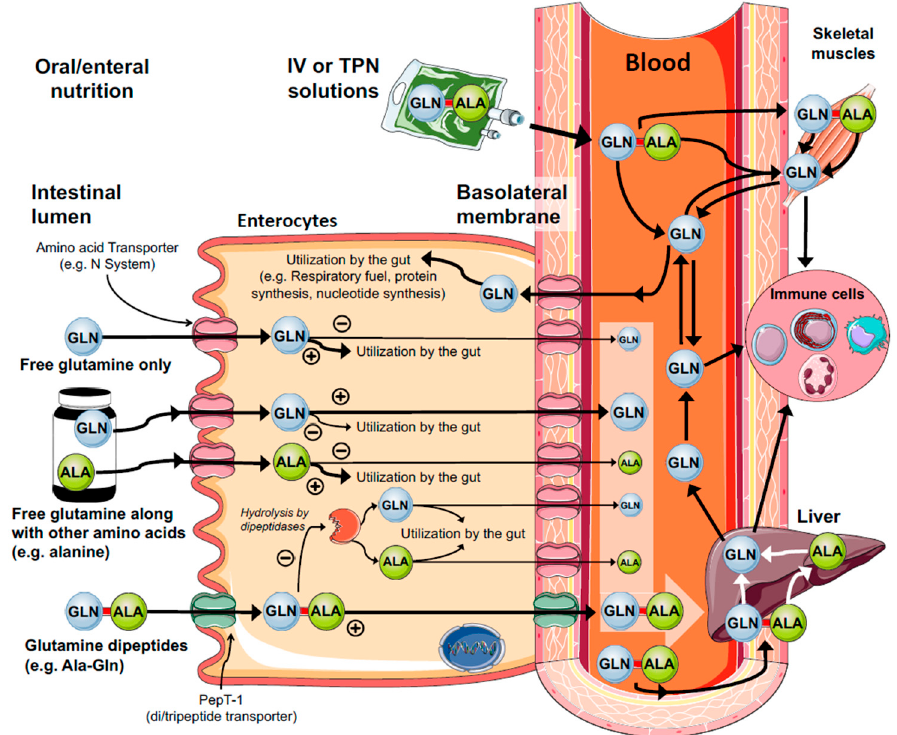
Figure 4. Mechanisms of enteral and parenteral glutamine (GLN) supply. Glutamine is an important substrate for rapidly dividing cells, such as enterocytes. This is a major site of glutamine consumption obtained from both exogenous/diet (luminal membrane) and/or endogenous glutamine synthesis (basolateral membrane). Free glutamine supplementation is mainly metabolized in the gut and poorly contribute to glutaminemia and tissue stores. On the other hand, glutamine dipeptides (e.g., Ala-Gln, Gly-Gln, Arg-Gln) escape from the gut metabolization and quickly supply glutamine to the plasma and target tissues. This effect is mainly attributed to the oligopeptide transporter 1 (Pept-1) located in the luminal membrane of the enterocytes.